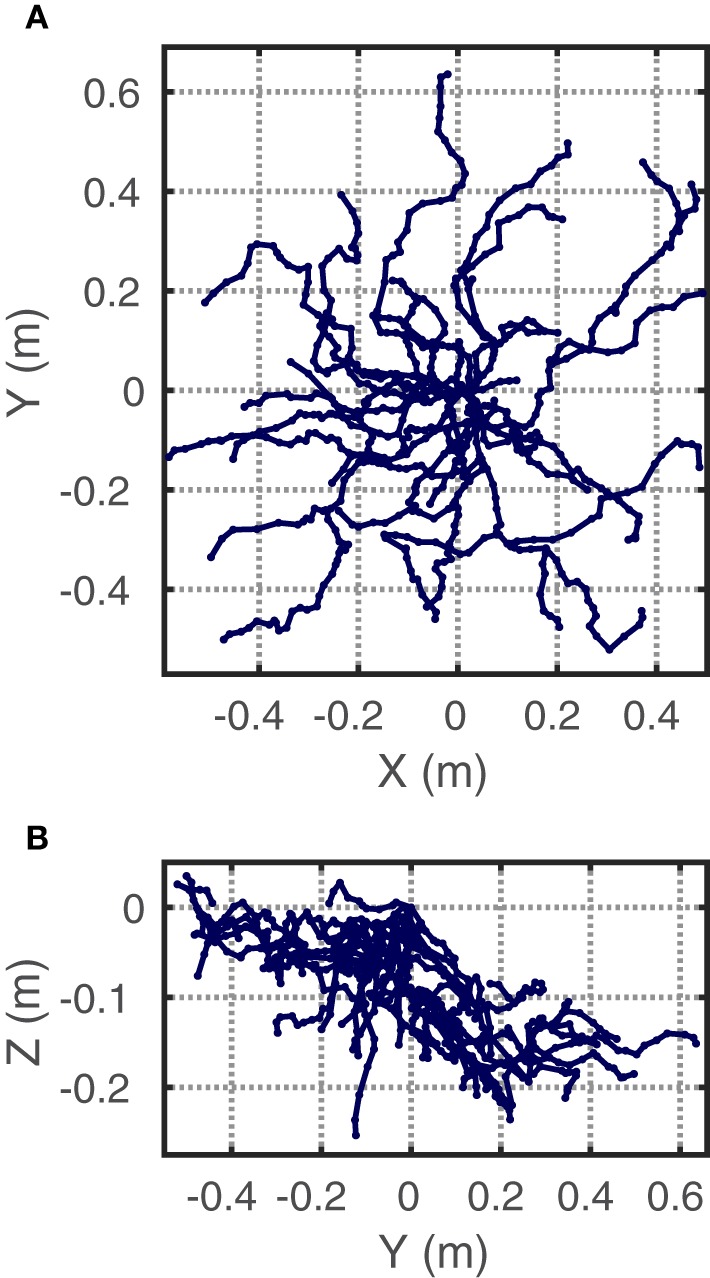
Example of the coarse root system representations used for box-counting. The data are piecewise linear interpolants constructed from the positional and topological data of a MTG of a Berberis thunbergii plant in (A) top- and (B) side-view. Grid origin set at root collar.